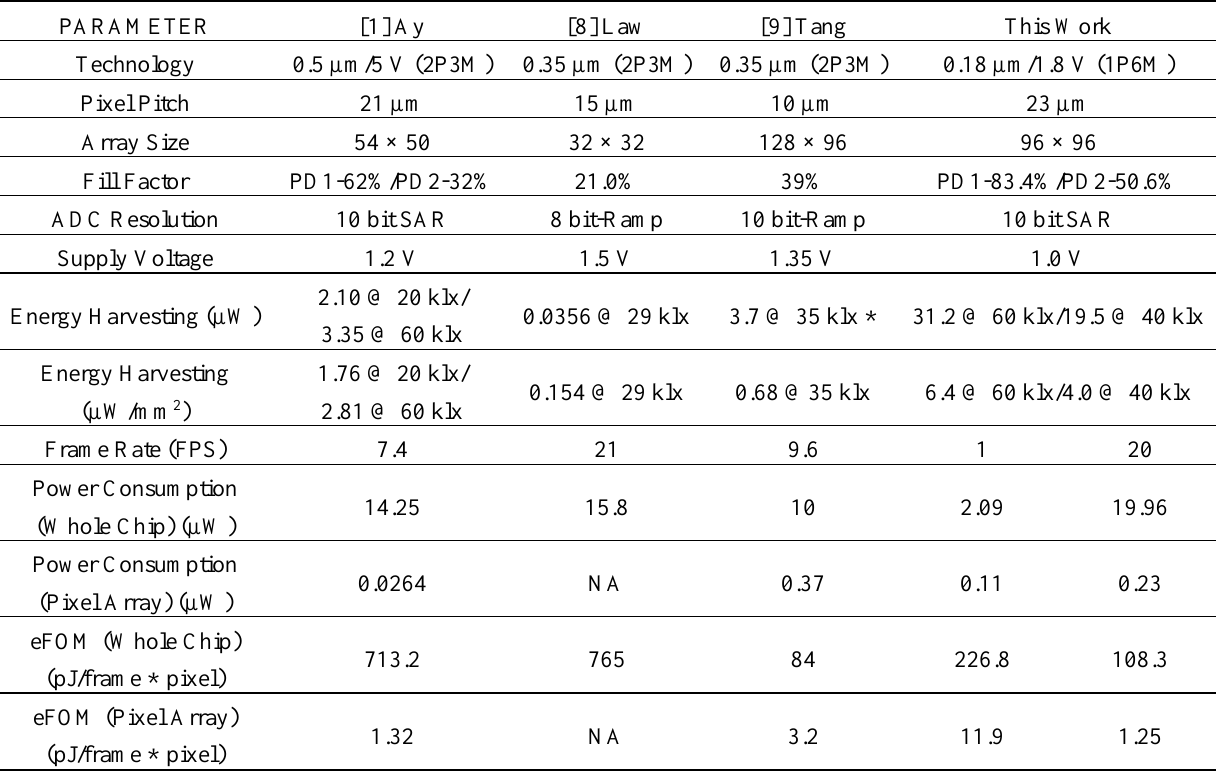
Table 4. Comparison of proposed imager to other energy harvesting imagers.